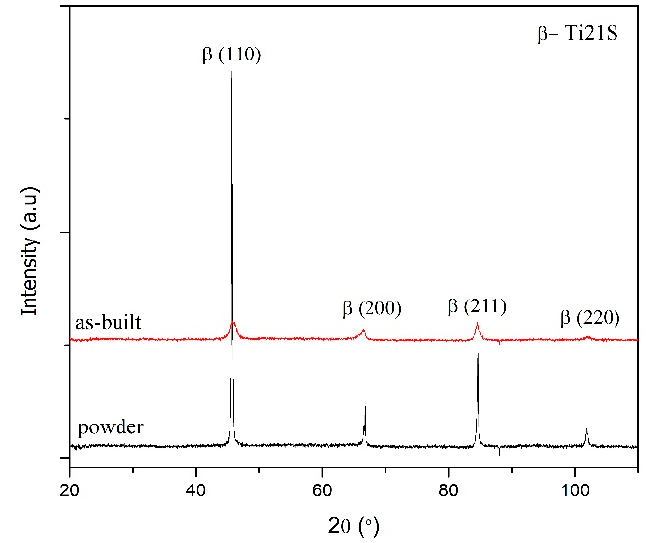
Figure 4. XRD patterns of initial powder and as-built β -Ti21S, fully stabilized β is the main phase in this system.